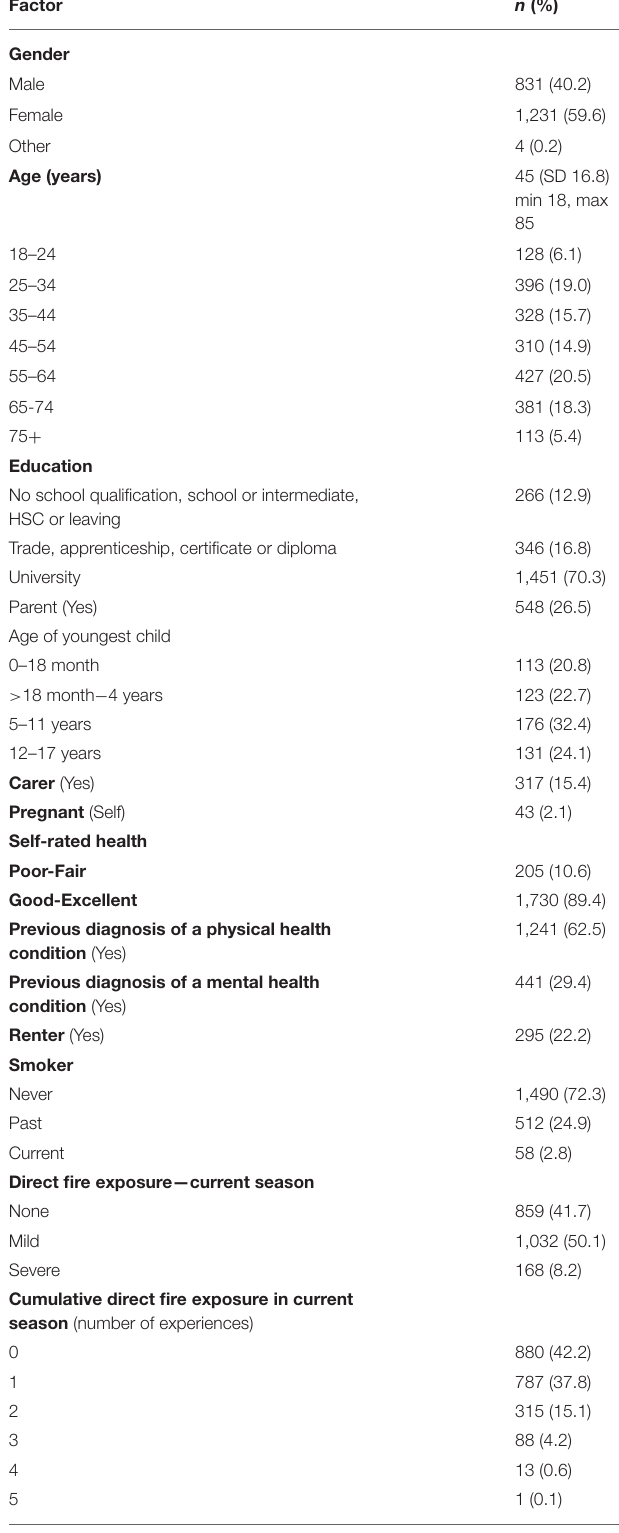
TABLE 1 | Description of sample